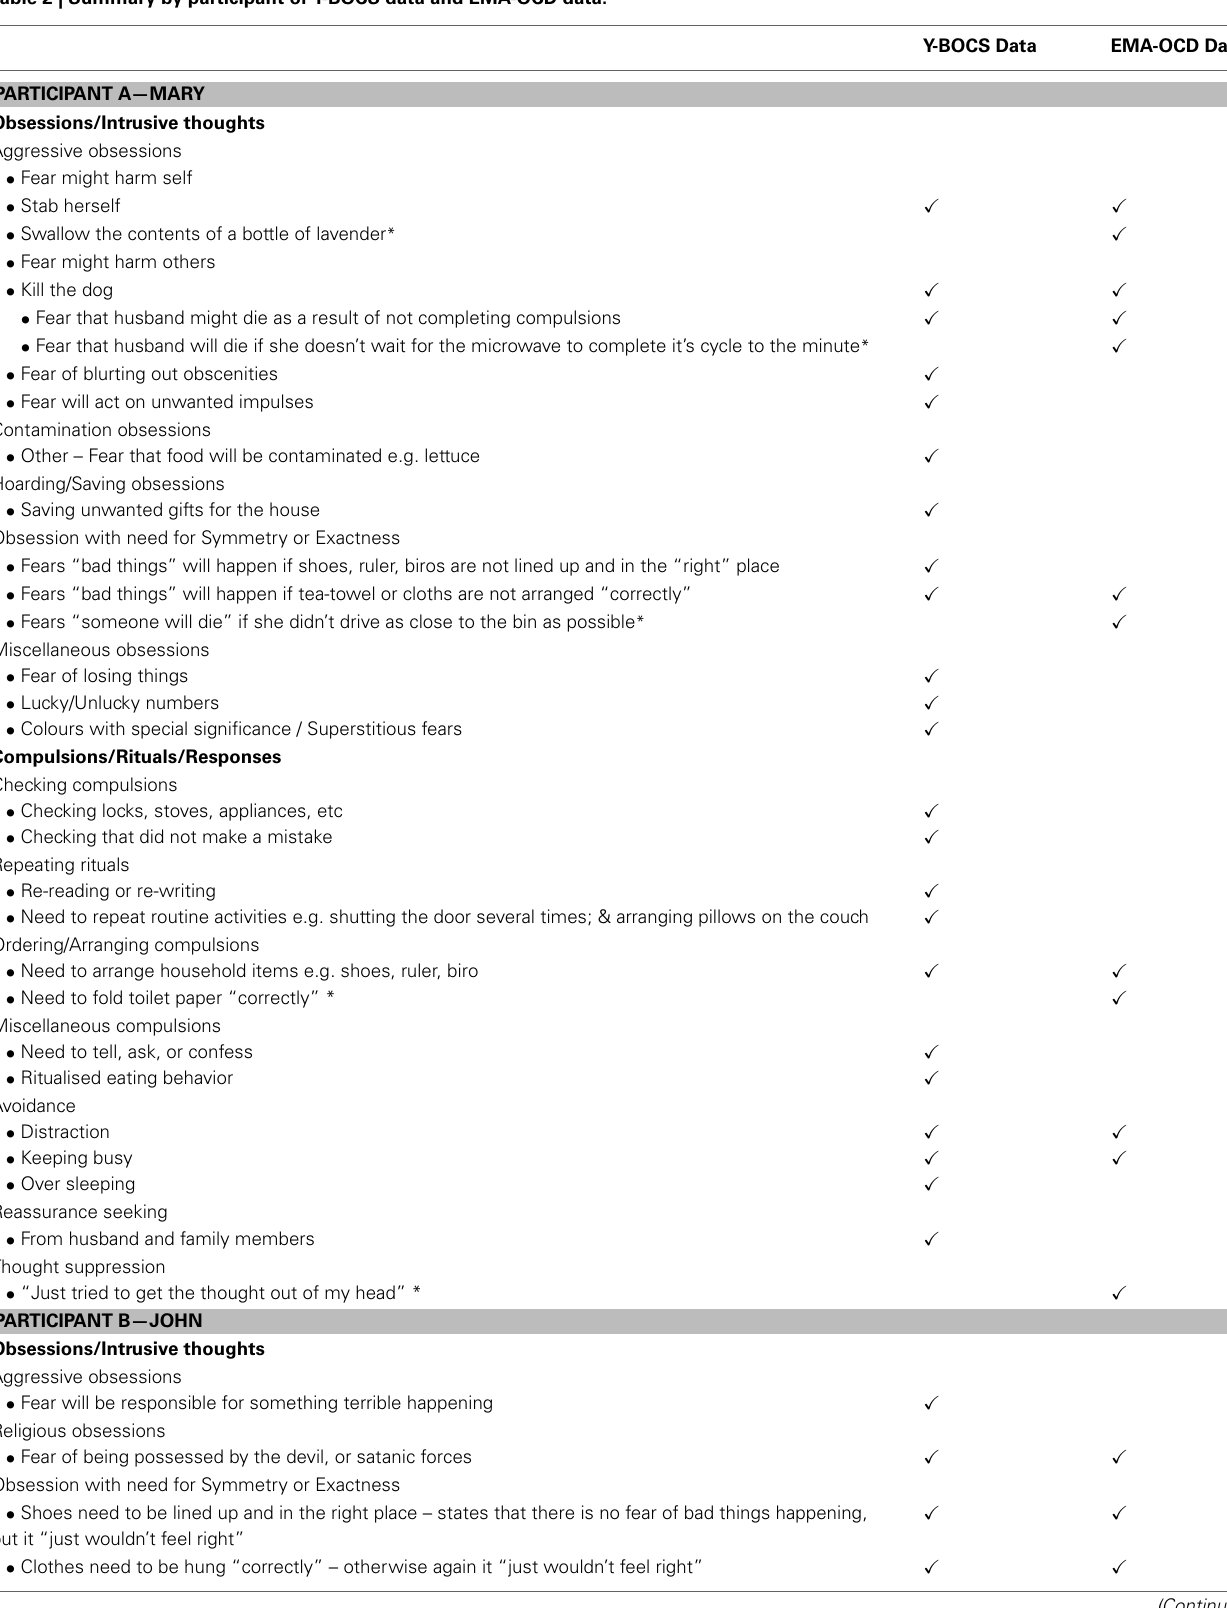
Table 2 | Summary by participant of Y-BOCS data and EMA-OCD